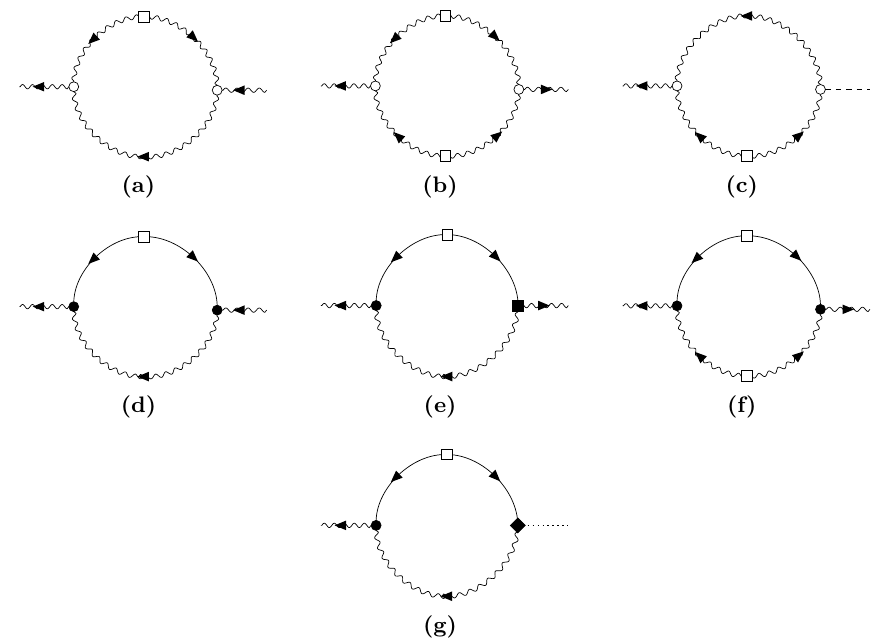
Figure 5. One-loop contributions to the response and correlation function in model H. Diagrams (a) and (b) contain the mode coupling interaction, diagram (c) is the vertex function that appears in the FD relation, and diagrams (d)-(g) are induced by multiplicative noise. The one-loop correction to the correlation function is shown in figure